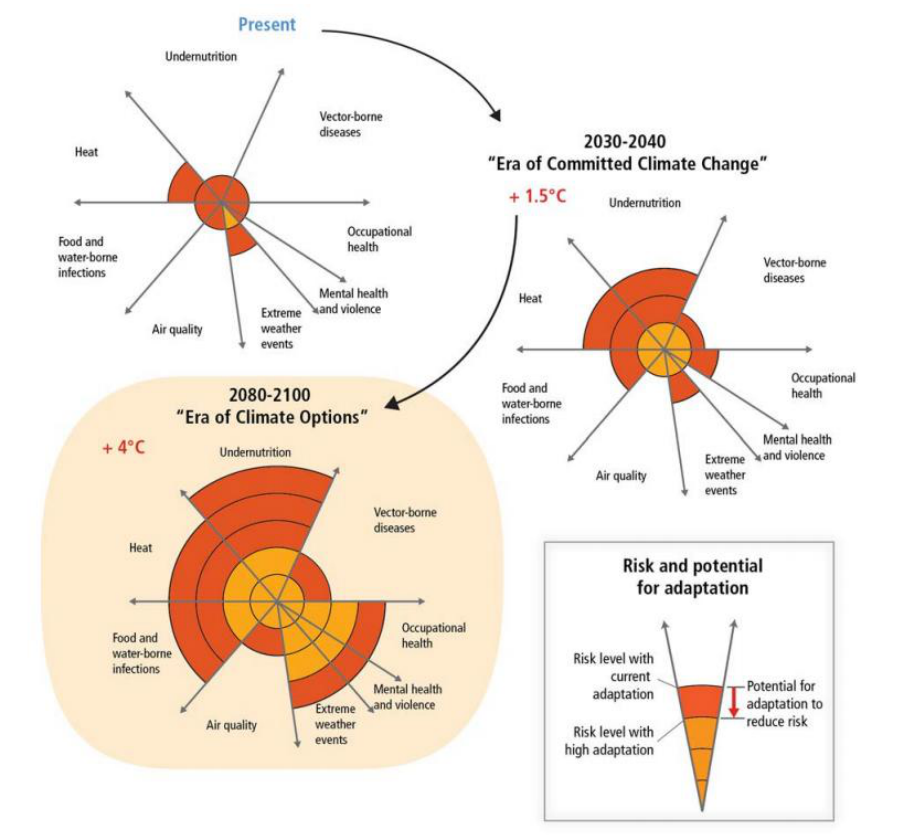
Figure 1. Conceptual presentation of the health impacts from climate change and the potential for impact reduction through adaptation (Source: